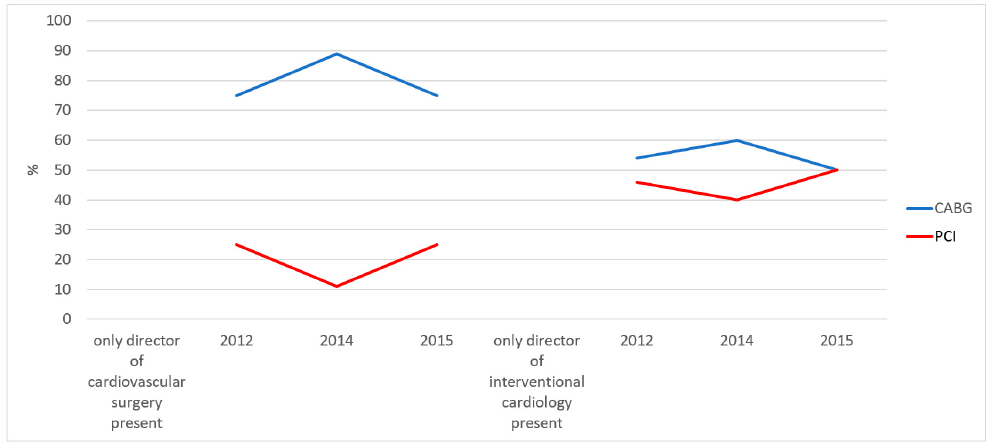
Figure 3. Evolution of Heart Team decisions over time related to the presence of the directors of the department of cardiovascular surgery ( left ) or the department of interventional cardiology ( right ). Legend: Bar chart of patients either scheduled for CABG ( blue line ) or PCI ( red line ). CABG = coronary artery bypass grafting; PCI = percutaneous coronary intervention.